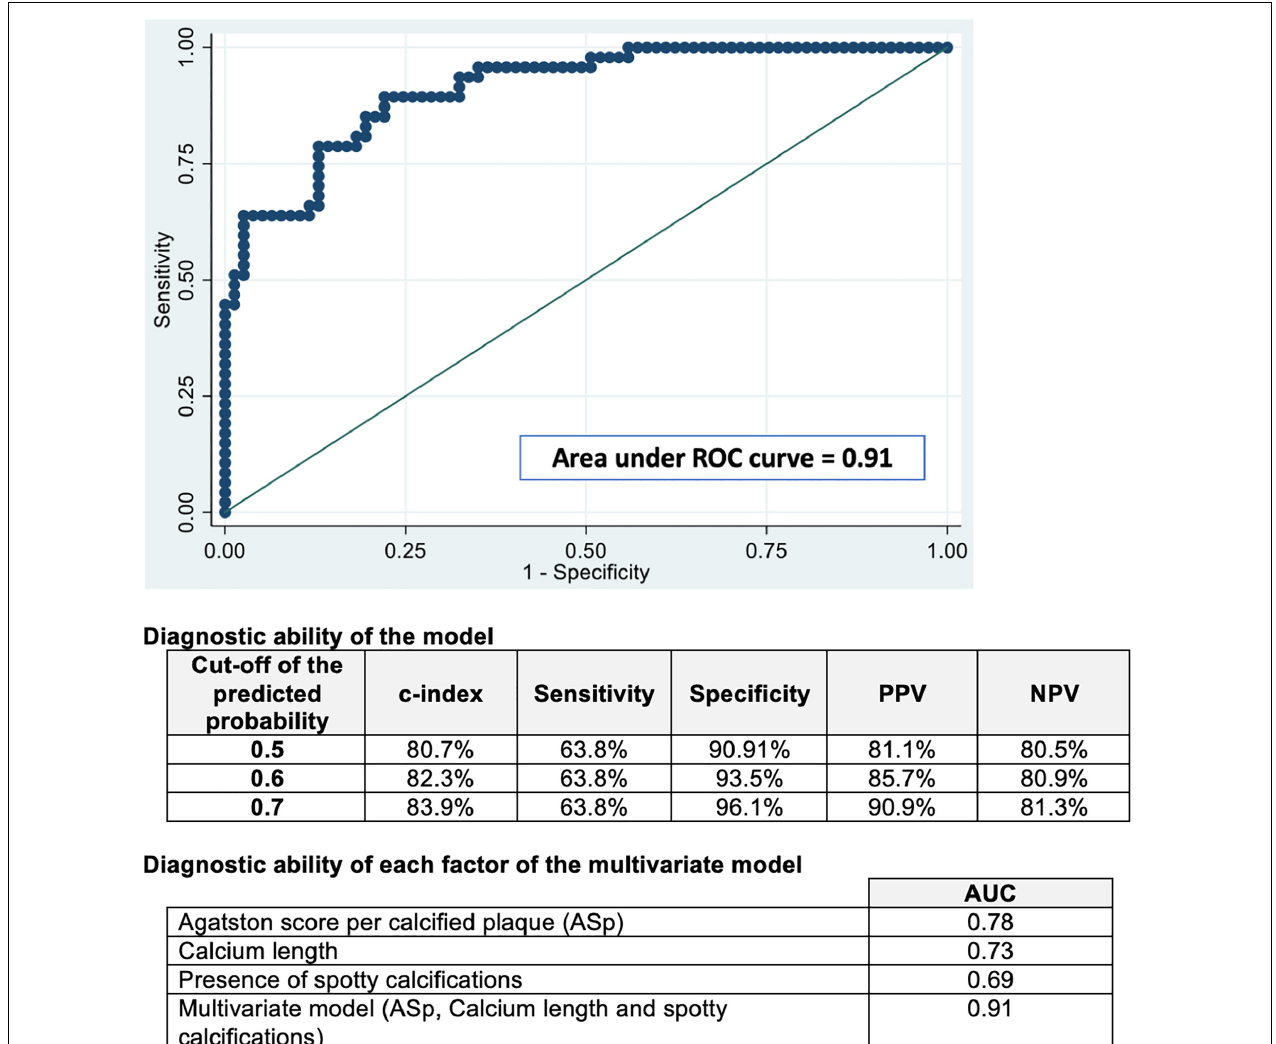
FIGURE 4 | ROC curve analysis for the detection of vulnerable plaques by the Agatston score plaque-specific, calcium length, and the presence of spotty calcifications. The receiver-operating characteristics (ROC) curve, area under the ROC curve, and Hosmer-Lemeshow goodness-of-fit tests for our model to predict the plaque vulnerability defined by OCT. Our model takes into account the Agatston score plaque-specific (ASp), the calcium length, and the presence of spotty calcifications, in addition to age and gender (AUC = 0.91). Abbreviations: AUC, area under the curve; ASp, Agatston score per calcified plaque; NPV, negative predictive value; PPV, positive predictive value; ROC, receiver operating